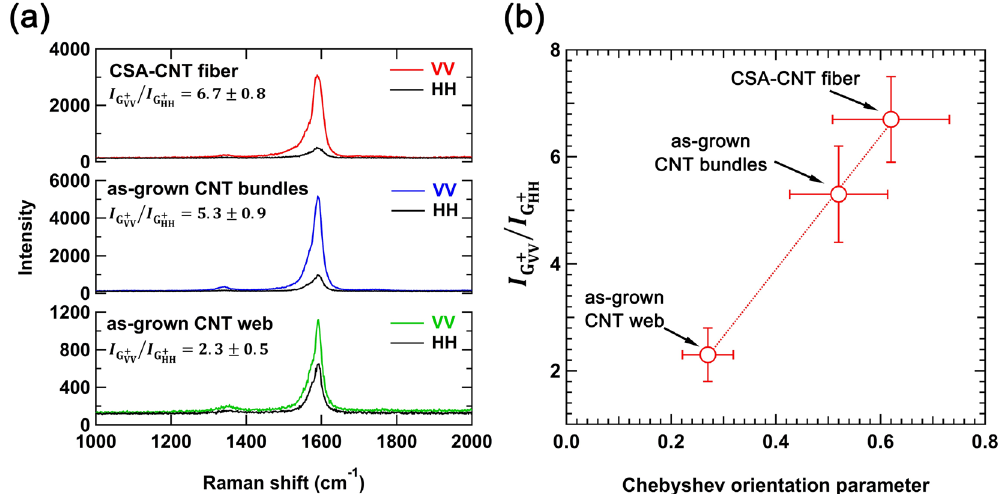
Figure 6. ( a ) Polarized Raman spectra of as-grown CNT web, as-grown CNT bundles, and CSA-CNT fiber, obtained with the VV and HH configurations. ( b ) Relationship between I G + orientation parameters of the CNT